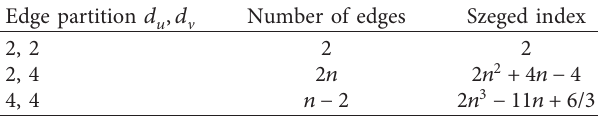
Table 3: Edge partition of oxide network of n order.